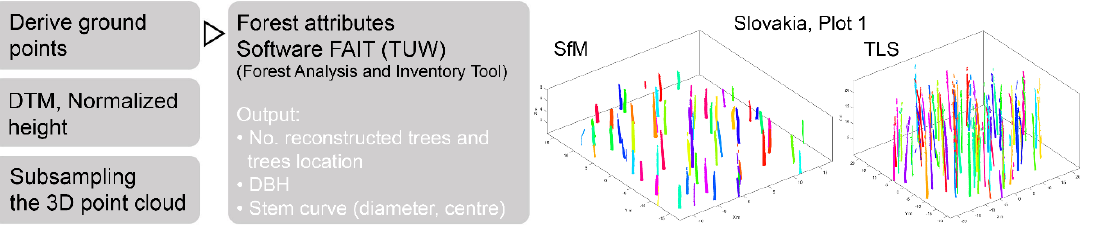
Figure 3. FAIT workflow to derive DBHs and the stem curves from a point cloud. On the right, an example of the stem modelling for plot 1 in Slovakia.